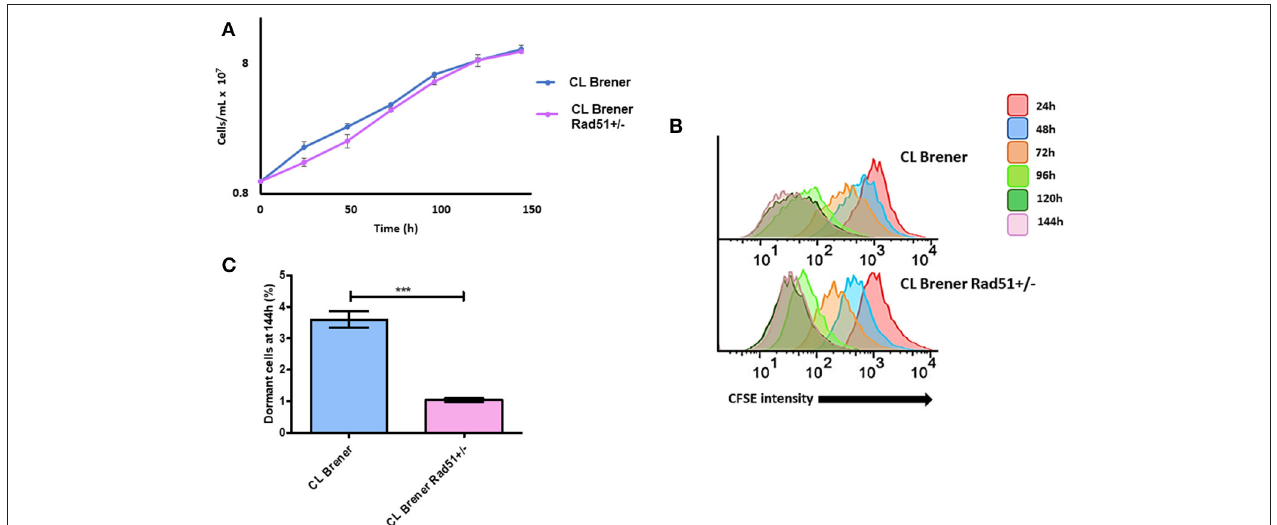
FIGURE 7 | Dormancy in epimastigote forms of T. cruzi CL Brener Rad51 + / − . (A) Cellular growth curve of CL Brener wild-type strain and Rad51 + / − mutant. At 0h, 1 × 10 7 cells were treated with CFSE, and samples were analyzed each 24h for 144h. (B) Flow cytometry histograms of epimastigote cultures from each strain. CFSE fluorescence intensity was followed every 24h until 144h. Cells that exhibited similar CFSE fluorescence intensity at 144h when compared to the level of half median of 24h were considered as dormants. (C) Average of dormant cells percentages in CL Brener and Rad51 + / − mutants at 144h was detected in flow cytometry histograms. Representative results of three experiments are shown. Asterisks indicate statistically significant differences among groups ( P -value < 0.05).